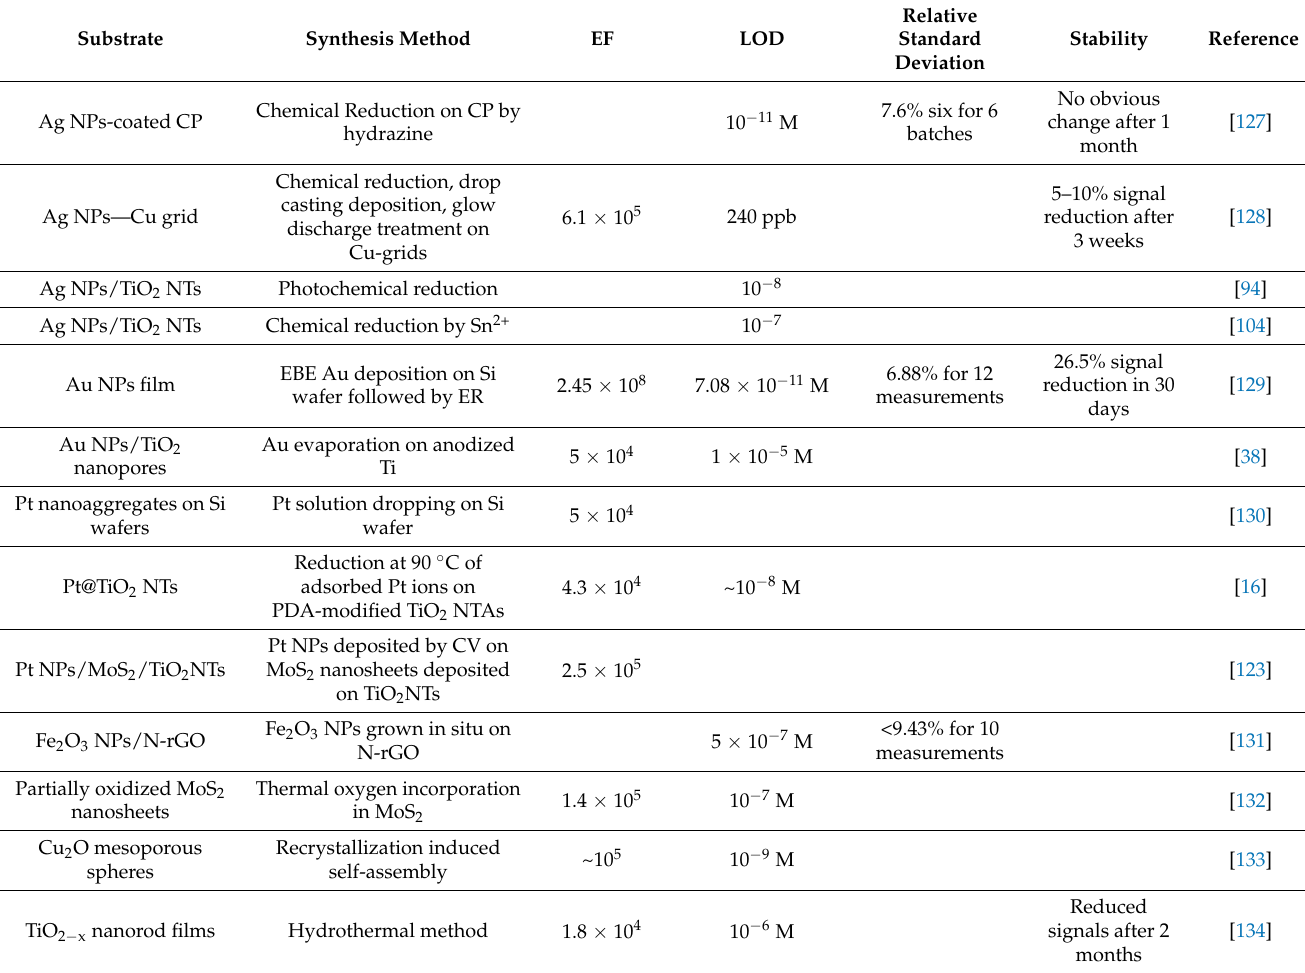
Table 4. Rhodamine 6G SERS analyses on different